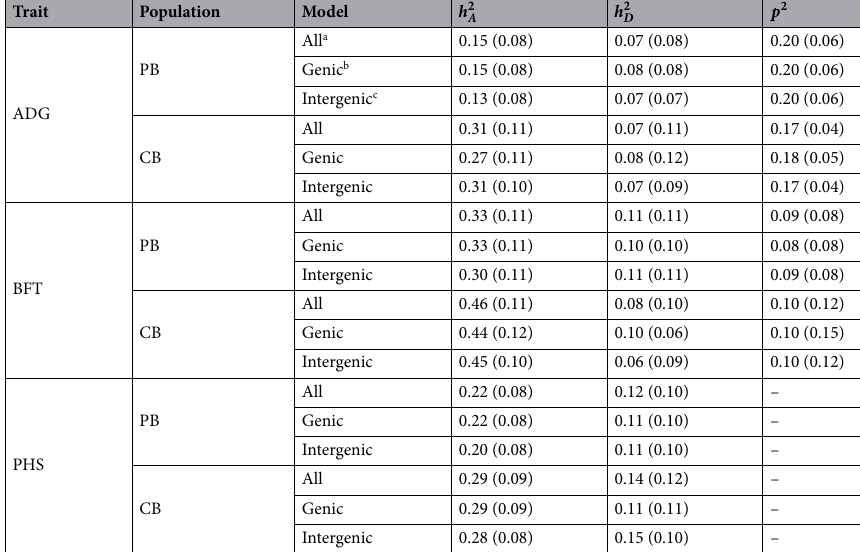
Table 2. Mean (SD) of the estimated marginal distribution of heritability ( h 2 A ), ratio of dominance variance ( h 2 D ), pen variance ( p 2 ) for average daily gain (ADG), backfat thickness (BFT) and pH semimembranosus (PHS) obtained with univariate genomic models in purebred (PB) and crossbred (CB) populations. a Univariate genomic model that used all SNPs available to compute additive and dominance genomic relationship matrices. b Univariate genomic model that used SNPs located in genic regions to compute additive and dominance genomic relationship matrices. c Univariate genomic model that SNPs located in intergenic regions to compute additive and dominance genomic relationship